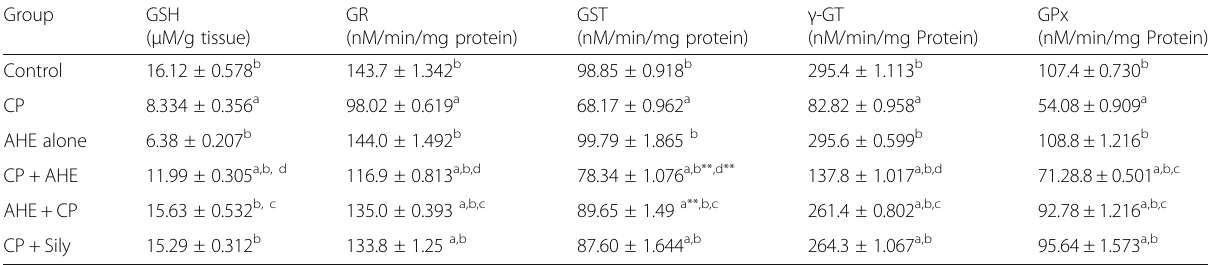
Table 4 Effect of cisplatin (CP) and different treatments of AHE on lungs tissue antioxidant enzymes and GSH profile Group